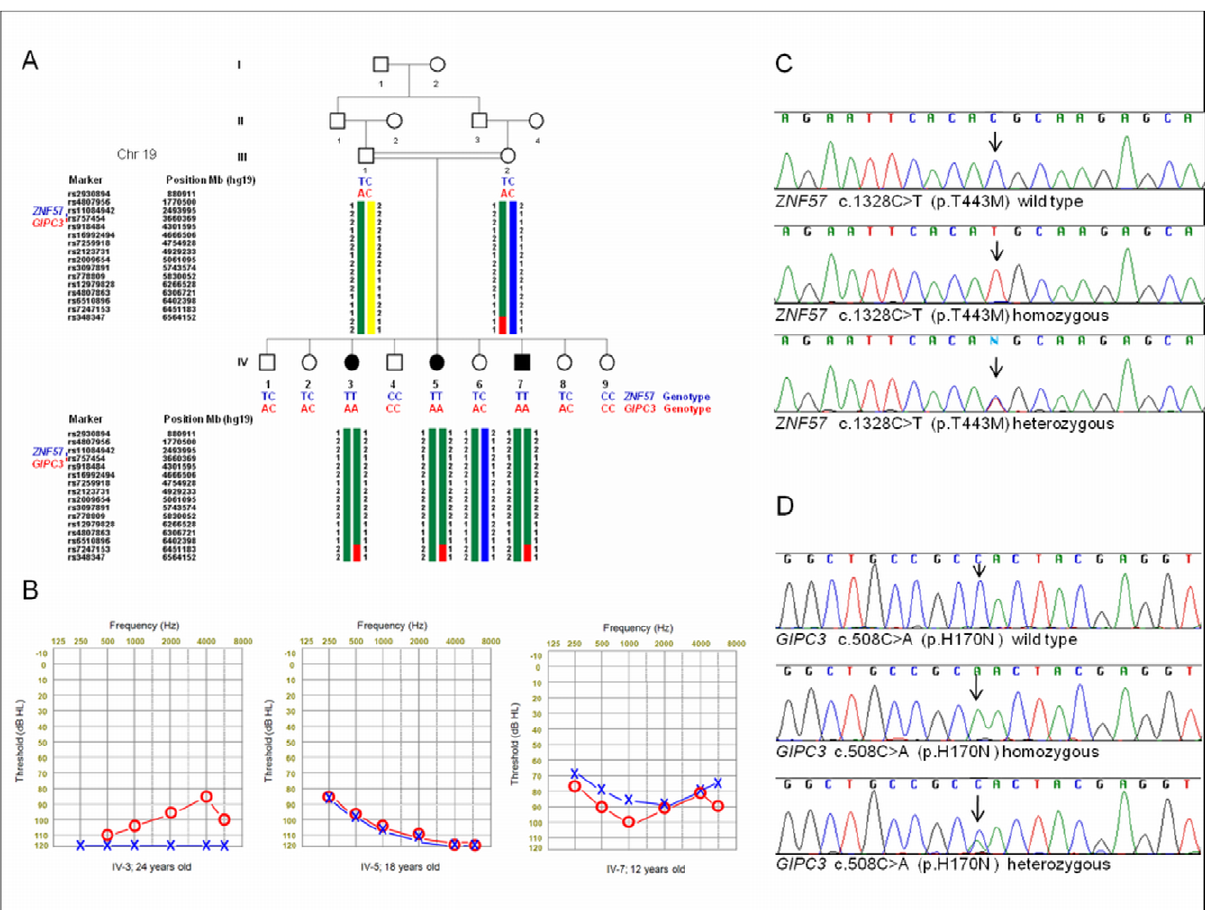
Figure 1. Pedigree with haplotypes, audiograms and two identified variants. (A) The pedigree and the third longest autozygous region on chromosome 19 that co-segregates with the phenotype. (B) Audiograms of affected members in the family. (C) Electropherograms showing the wild type, homozygous and heterozygous forms of the variant p.T443M in ZNF57 . (D) Electropherograms showing the wild type, homozygous and heterozygous form of the variant p.H170N in GIPC3